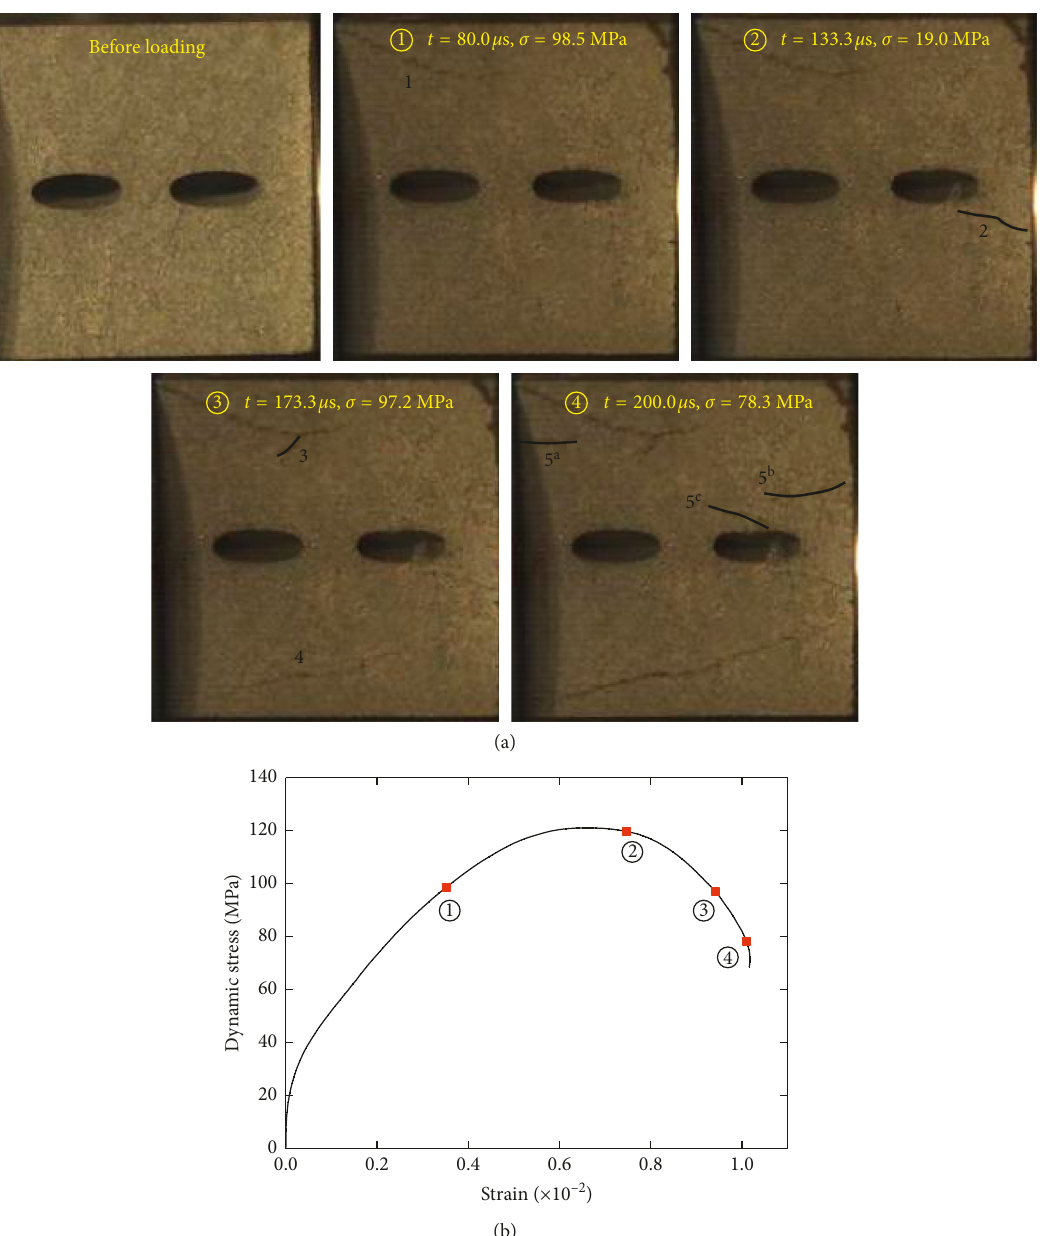
Figure 16: Fracturing process of type I mode with its corresponding dynamic stress-strain curve ( α